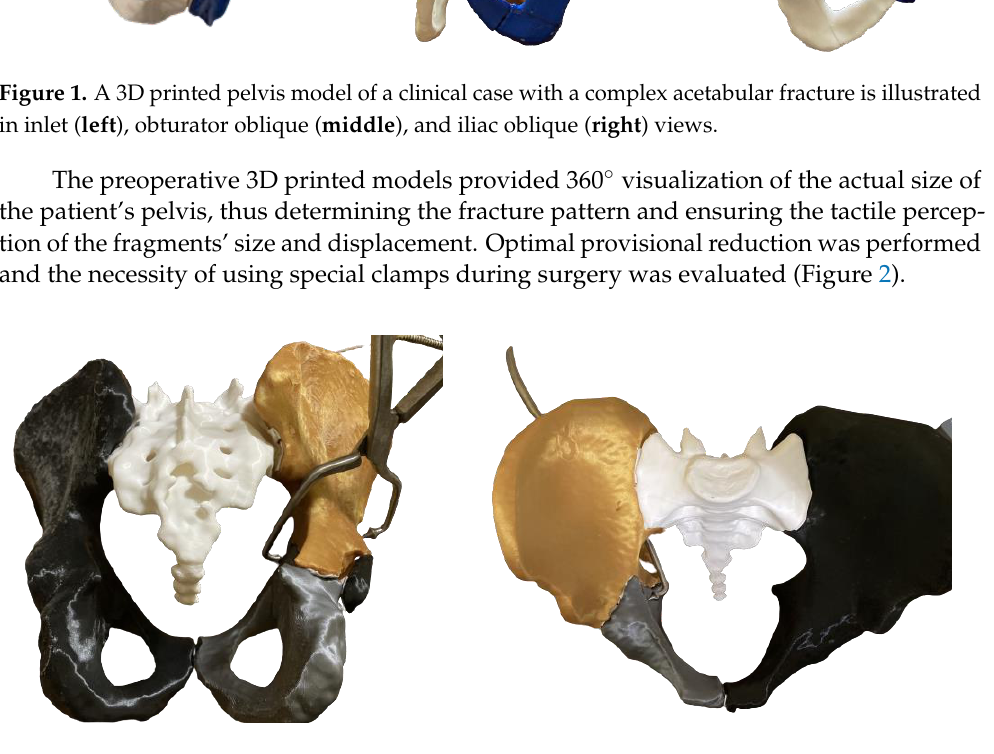
Figure 2. Provisional reduction and placement of the asymmetric clamp through the greater sciatic notch are illustrated in posterior ( left ) and top ( right ) views.